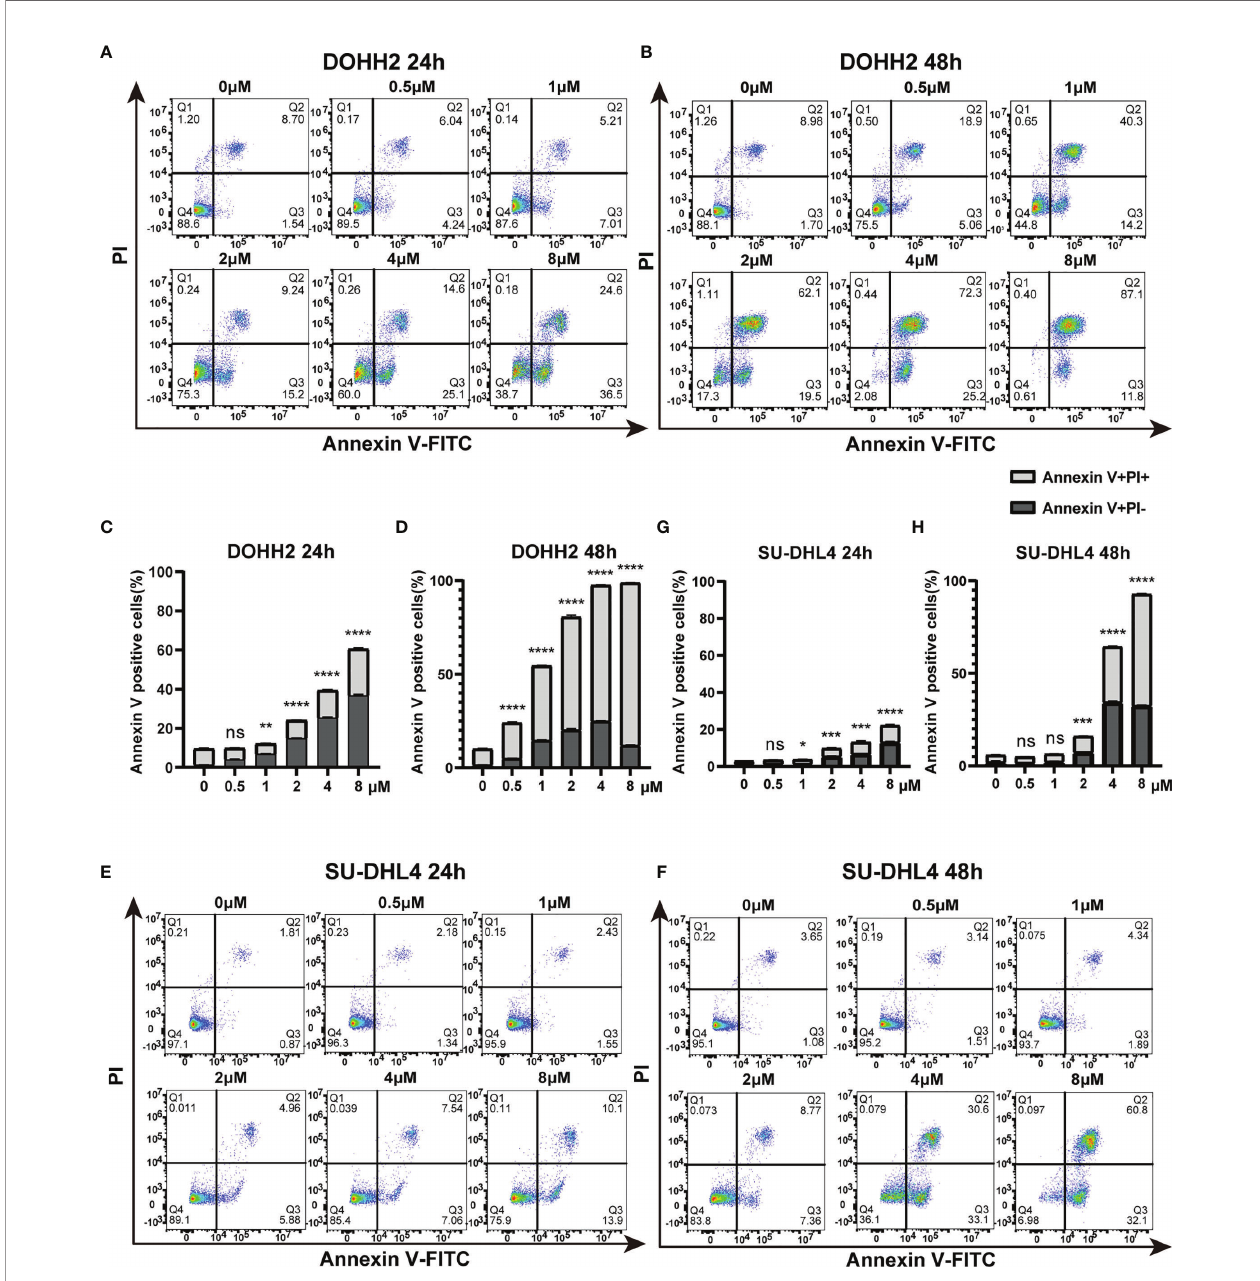
FIGURE 2 | Chidamide induces apoptosis in highly sensitive FL DOHH2 and SU-DHL4 cells. (A, B) DOHH2 and (E, F) SU-DHL4 cells were treated with various doses of chidamide for 24 h or 48 h, after which the percentages of apoptotic cells were examined by Annexin V/PI double staining. The levels of apoptotic cells were remarkably increased at the indicated times of exposure to chidamide in (C, D) DOHH2 and (G, H) SU-DHL4 cells. Data are mean±S.D. (* p < 0.05; ** p < 0.01; *** p < 0.001; **** p < 0.0001; NS, p >